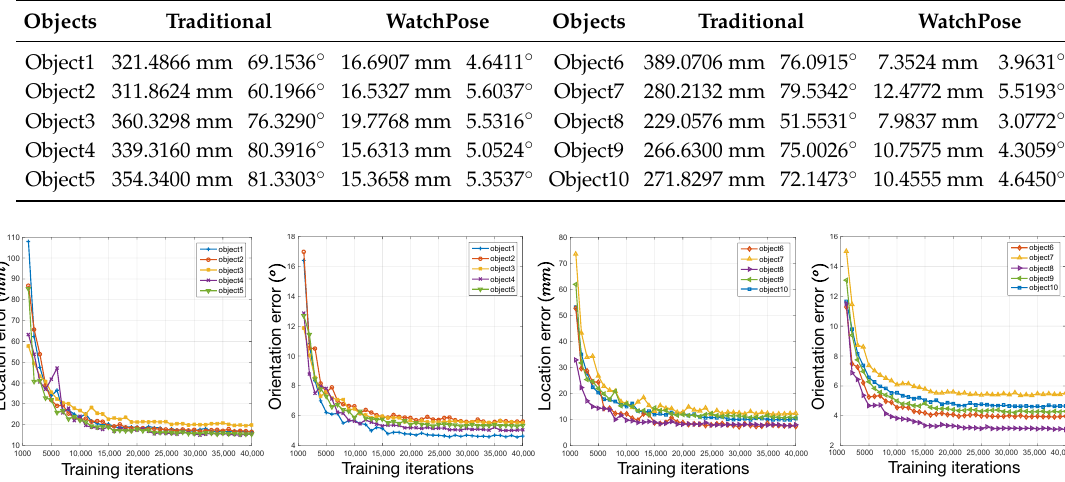
Figure 14. Estimated camera location and orientation errors of 10 objects in each training iteration.